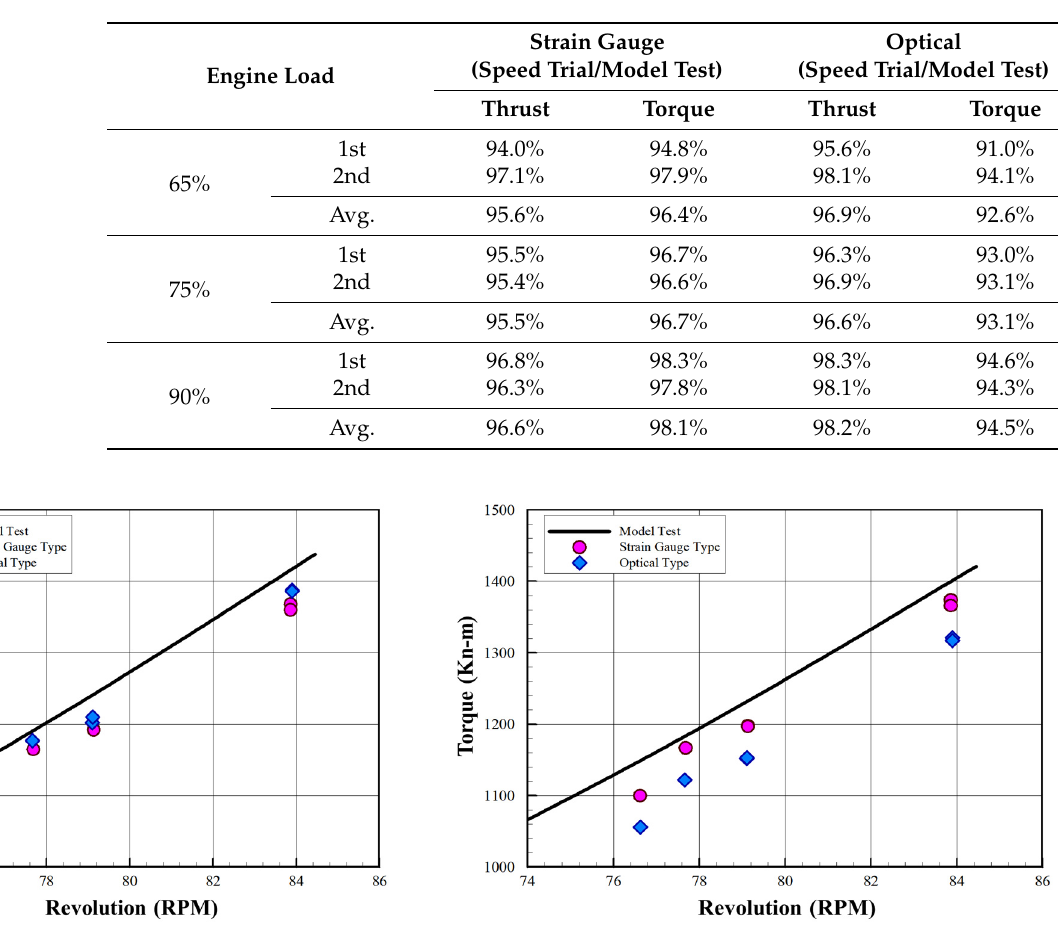
Figure 8. Comparison of thrust and torque between speed trials and prediction results based on model test of the second vessel.